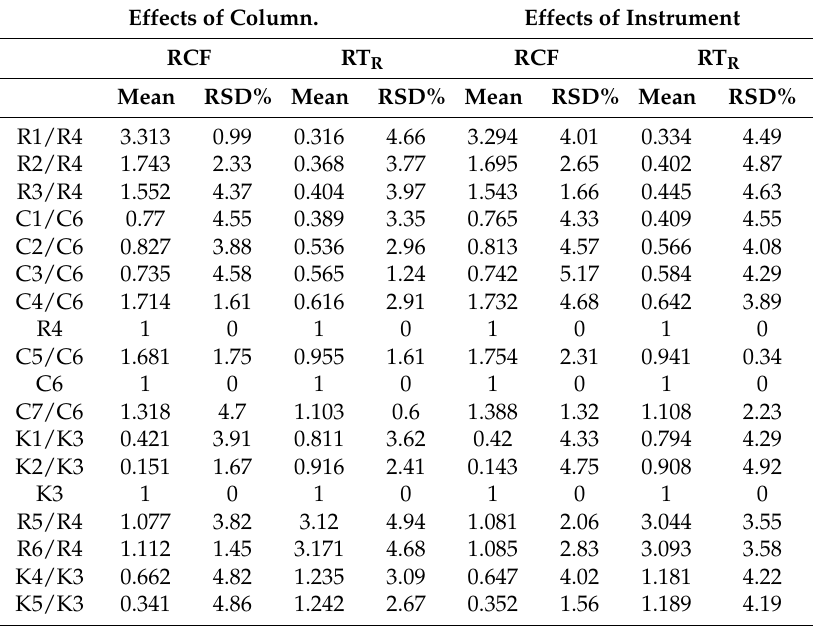
Table 3. Effects of columns and instruments upon RCF and RT R. Effects of Column.